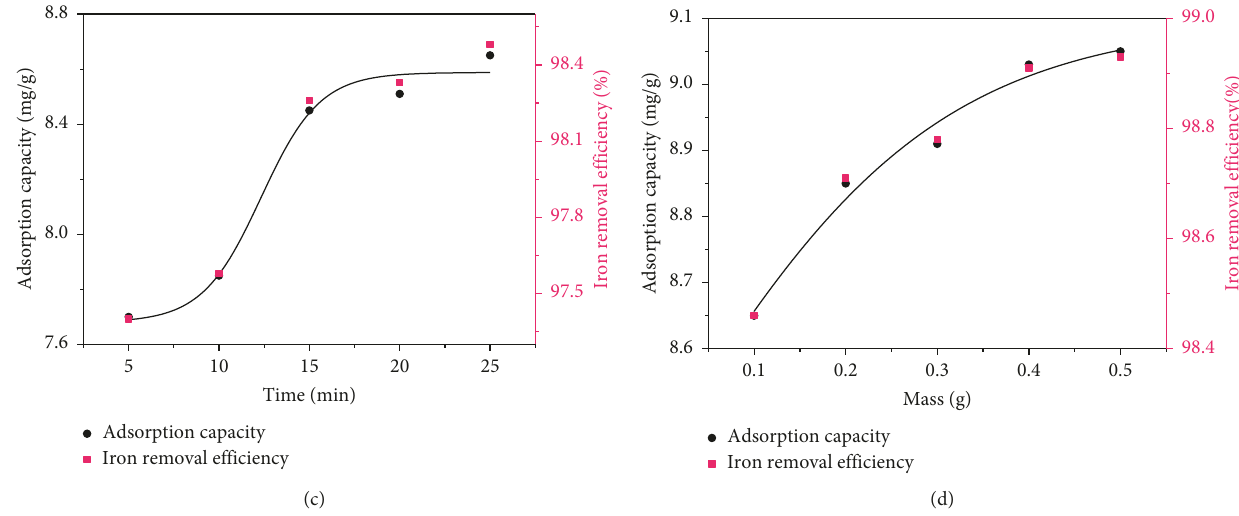
Figure 3: Experimental results of Fe 2+ adsorption capacity and Fe 2+ removal efficiency by the SiO calibration curve for Fe 2+ ion adsorption and effect of (b) pH, (c) contact time, and (d) SiO 2